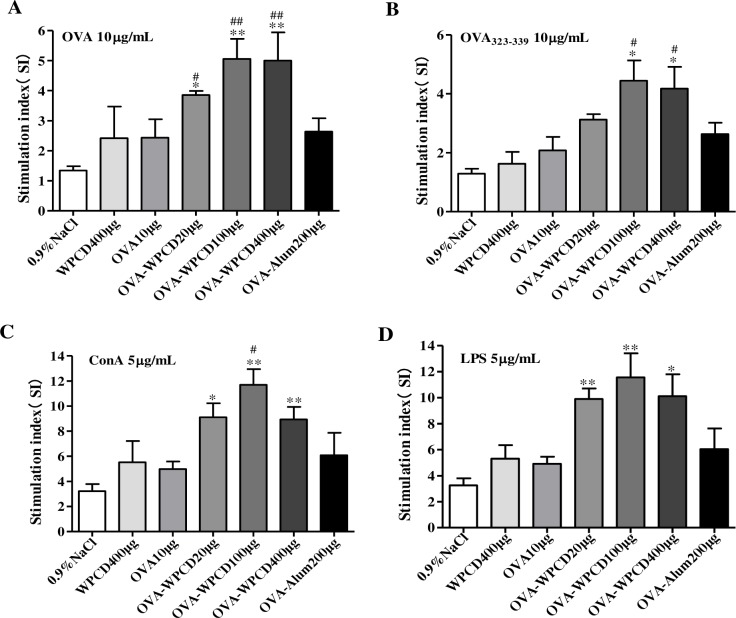
Effects of WPCD on the splenocyte proliferation.Single splenocyte was isolated from mice immunized on day 21 after the first vaccination and splenocyte proliferation was determined by the MTT assay and expressed as SI. OVA-antigen stimulated splenocyte proliferation (A). OVA323-339-antigen stimulated splenocyte proliferation (B). ConA-mitogen stimulated splenocyte proliferation (C). LPS-mitogen splenocyte proliferation (D). Data are expressed as mean ± SD (n = 5) from 3 independent experiments. *P < 0.05, ** P < 0.01 compared with the OVA group; #P < 0.05, ##P < 0.01 compared with the OVA/Alum group.